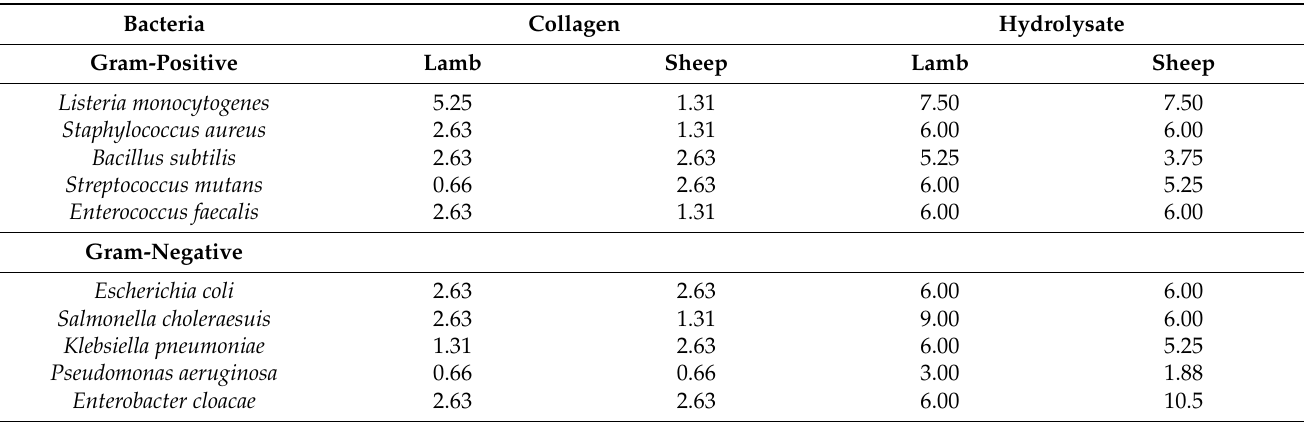
Table 3. Minimum inhibitory concentration (%) of samples of collagens and hydrolysates to inhibit the growth of Gram-positive and Gram-negative